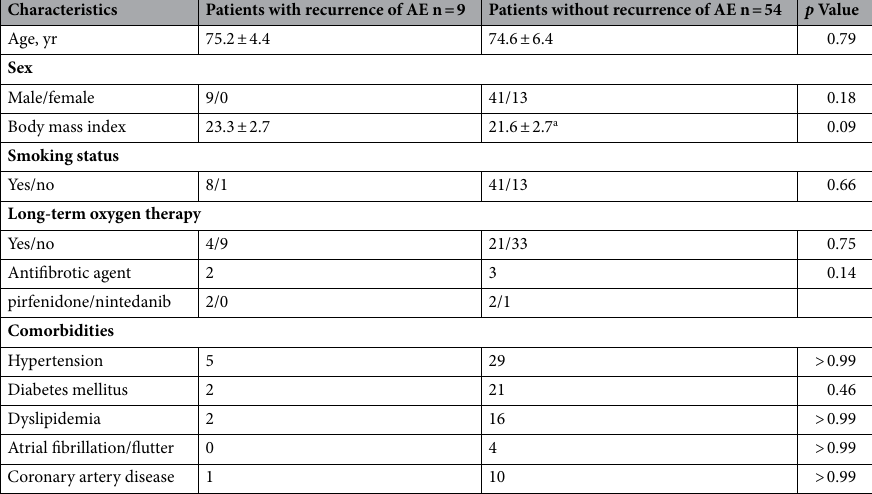
Table 1. Baseline characteristics of patients with IPF and treatment of IPF at discharge of the first acute exacerbation. Values are shown as actual numbers or means ± standard deviation. a n = 45. AE acute exacerbation, DLco diffusing capacity of lungs for carbon monoxide, FEV 1 forced expiratory volume in 1 s, FVC forced vital capacity, IPF idiopathic pulmonary